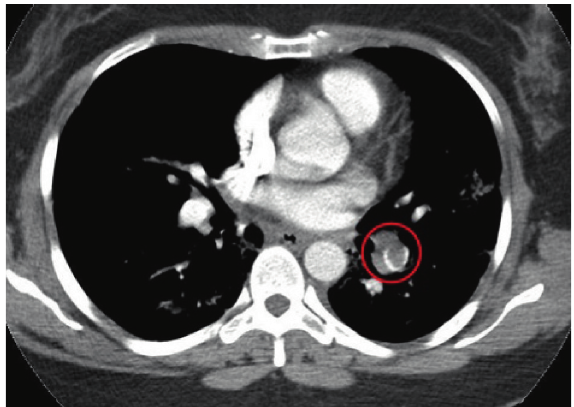
Figure 4: Chest axial CTA image on a vascular window shows a filling defect (circle) in the left lower lobe consistent with lobar and segmental pulmonary embolism.